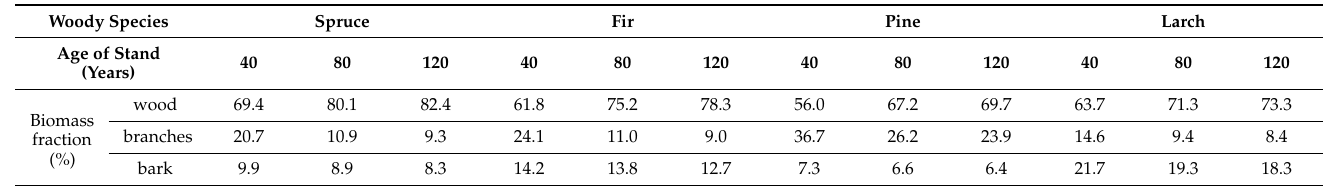
Table 2. The development of shares of energy reserves in biomass fractions of stands with a medium site index (30, in the case of pine 24).